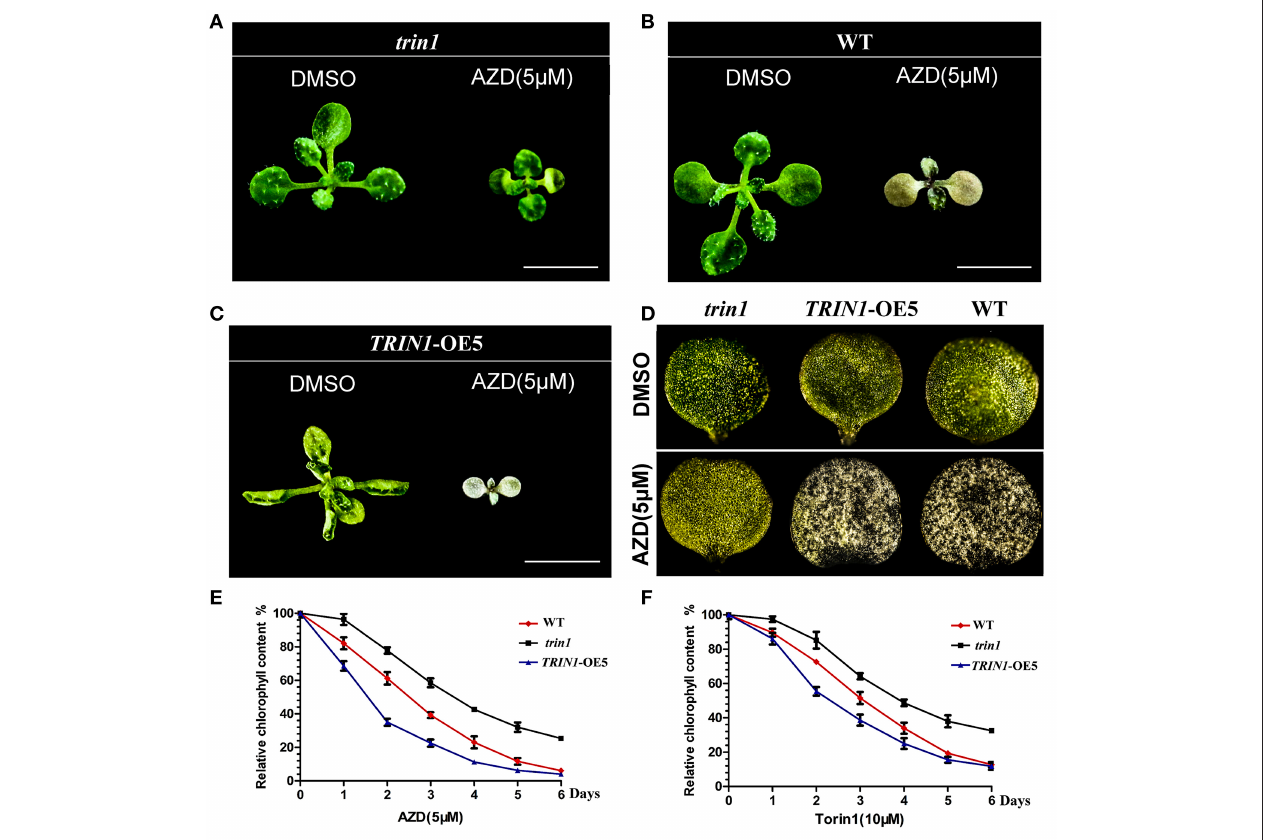
FIGURE 4 | The effect of AZD on the phenotype of trin1 mutant and TRIN1 -OE5 plants. (A – C) The phenotype of trin1 , TRIN1 -OE5, and WT plants, 10-day-old seedlings were transferred to ½ MS medium treated for 5 days with or without 5 µ M AZD. Bar = 5mm. (D) Images of the first cotyledon of trin1 , TRIN1 -OE5, and WT plants treated as described in (A–C) were captured under a stereomicroscope (2.5 × magnification). (E,F) Seeds of WT, trin1, and TRIN1 -OE5 were cultured on ½ MS for 7 days. Then, the seedlings were treated for 0–6 days with 5 µ M AZD or 10 µ M Torin1, and the relative chlorophyll content of plant leaves were measured. The data represents the mean ± SD of n = 3 independent